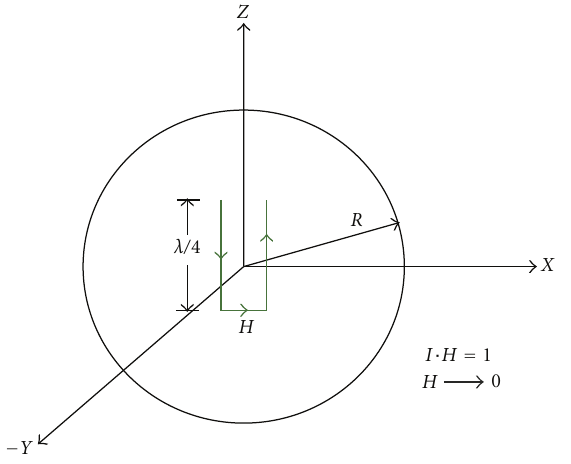
Figure 7: A finite-size spherical radiator carrying a finite-surface current density, for which its fields outside the sphere are exactly the same as the fields of the U-shaped λ/ 4 power isotropic radiator. The radius of the sphere is R = λ/